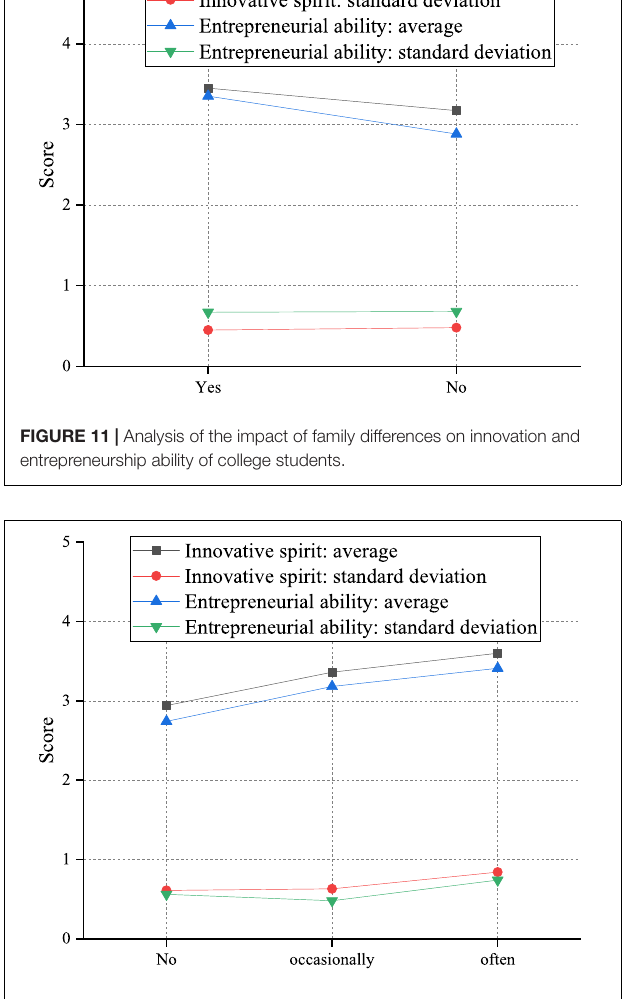
FIGURE 12 | Influence of college students’ participation in theory courses on innovation and entrepreneurship ability.